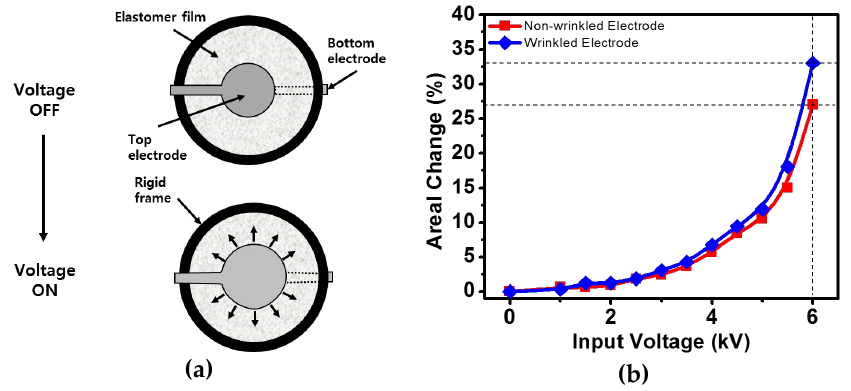
Figure 5. Actuation behaviors: ( a ) concept of isotropic elastomer actuation, ( b ) comparison of areal changes of wrinkle-free and wrinkled elastomer actuator.